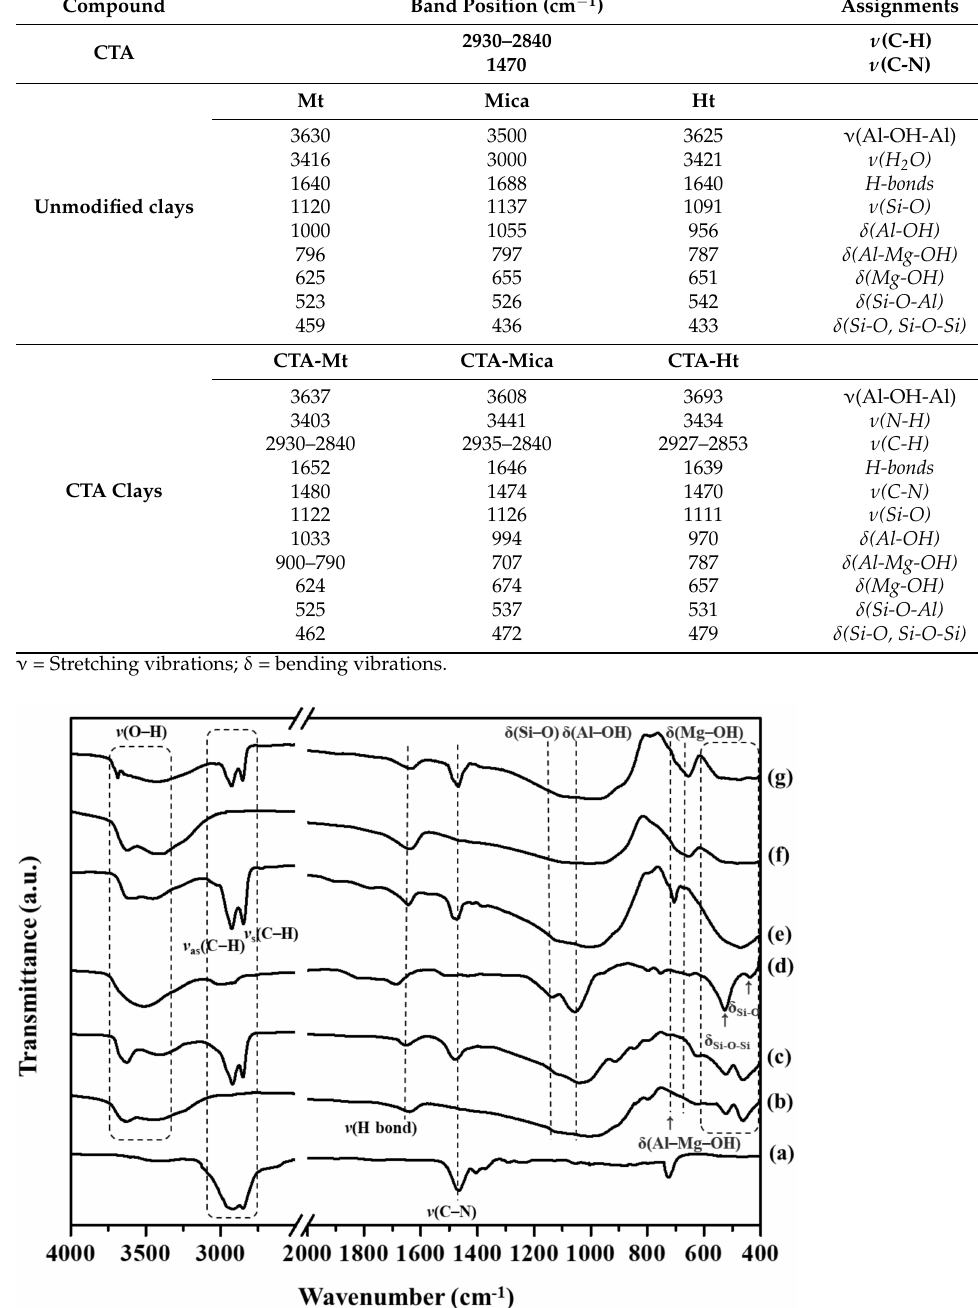
Table 1. FT-IR analysis of CTA, unmodified clays, and CTA clays.